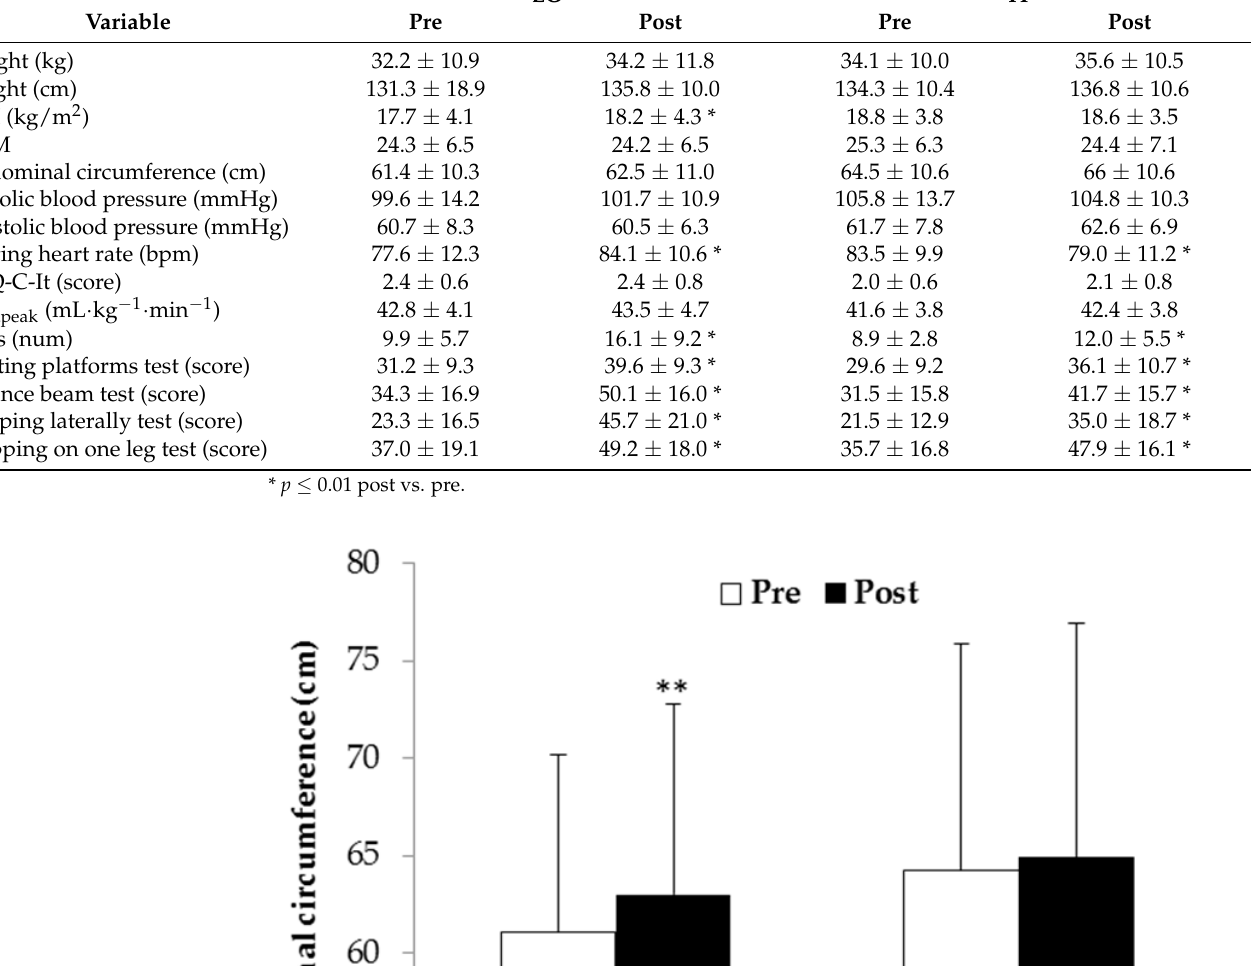
= 4.05, p = 0.047, η 2 = 0.043) revealed that girls had 1,91